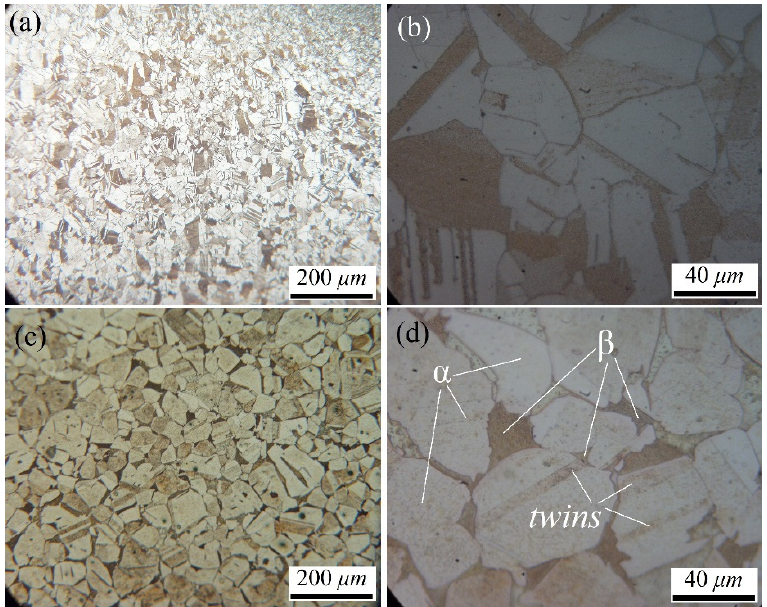
Figure 2. OM images of the single-phase ( a , b ) and double-phase ( c , d ) brasses at low and high magnifications. The magnification of ( a , c ) is 200×, and the magnification of ( b , d ) is 1000×.